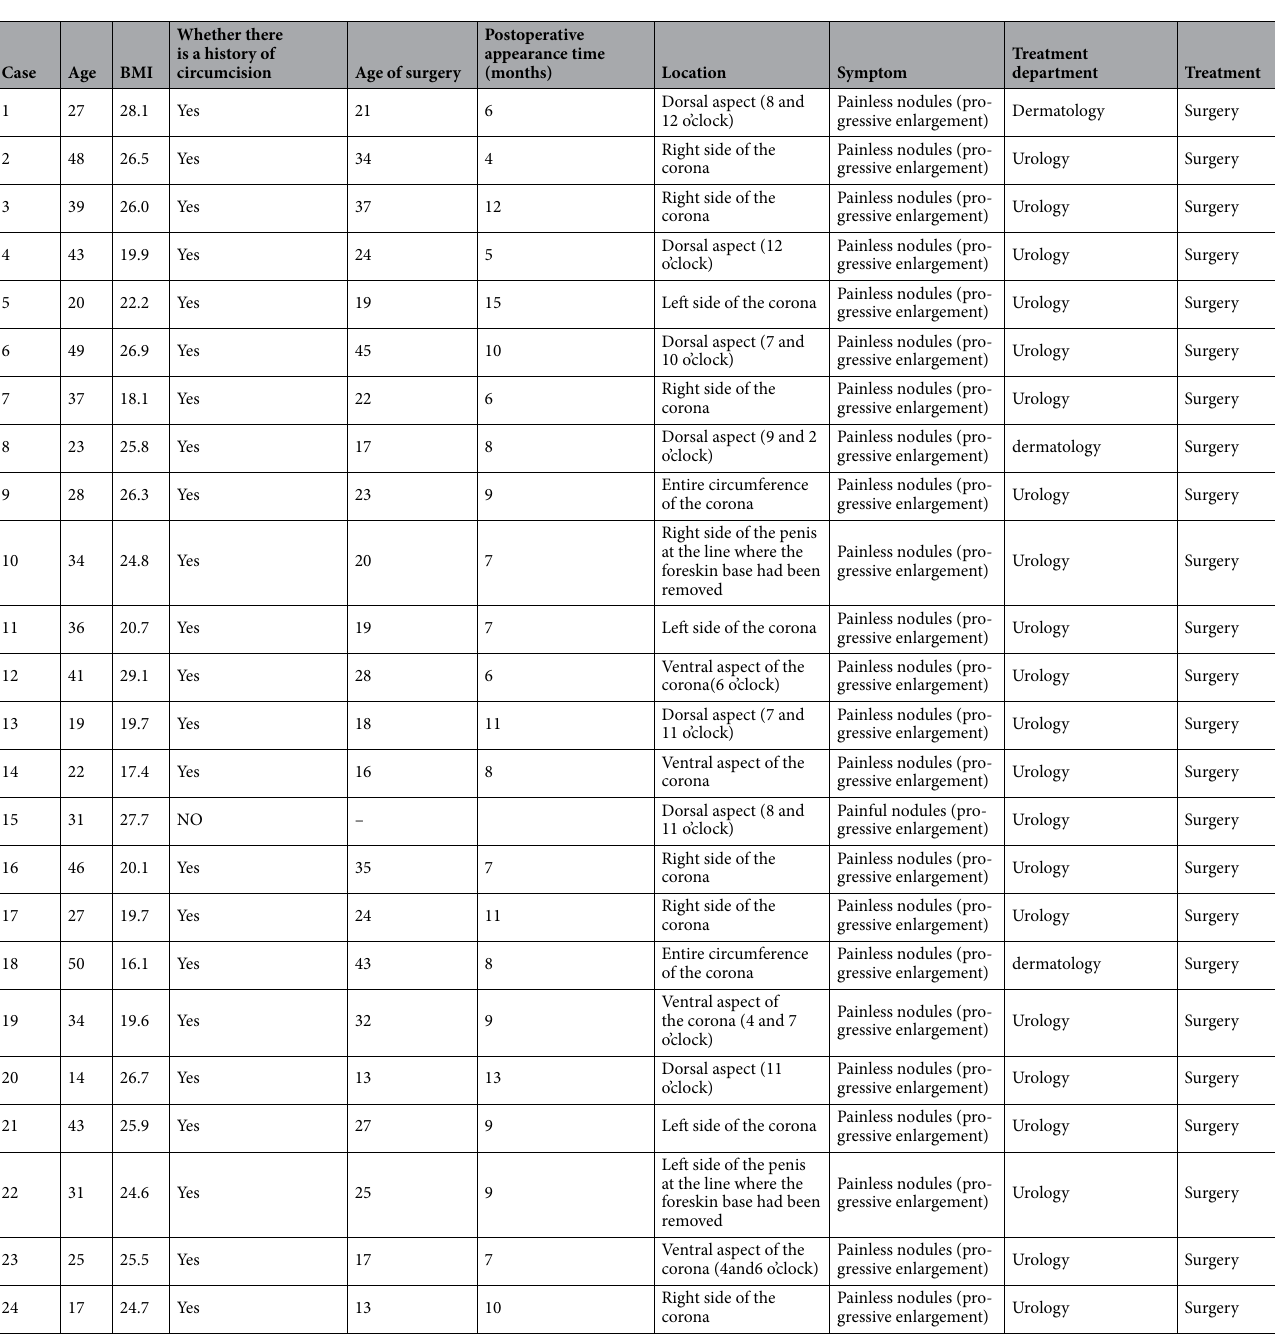
Table 1. Basic information of patients.